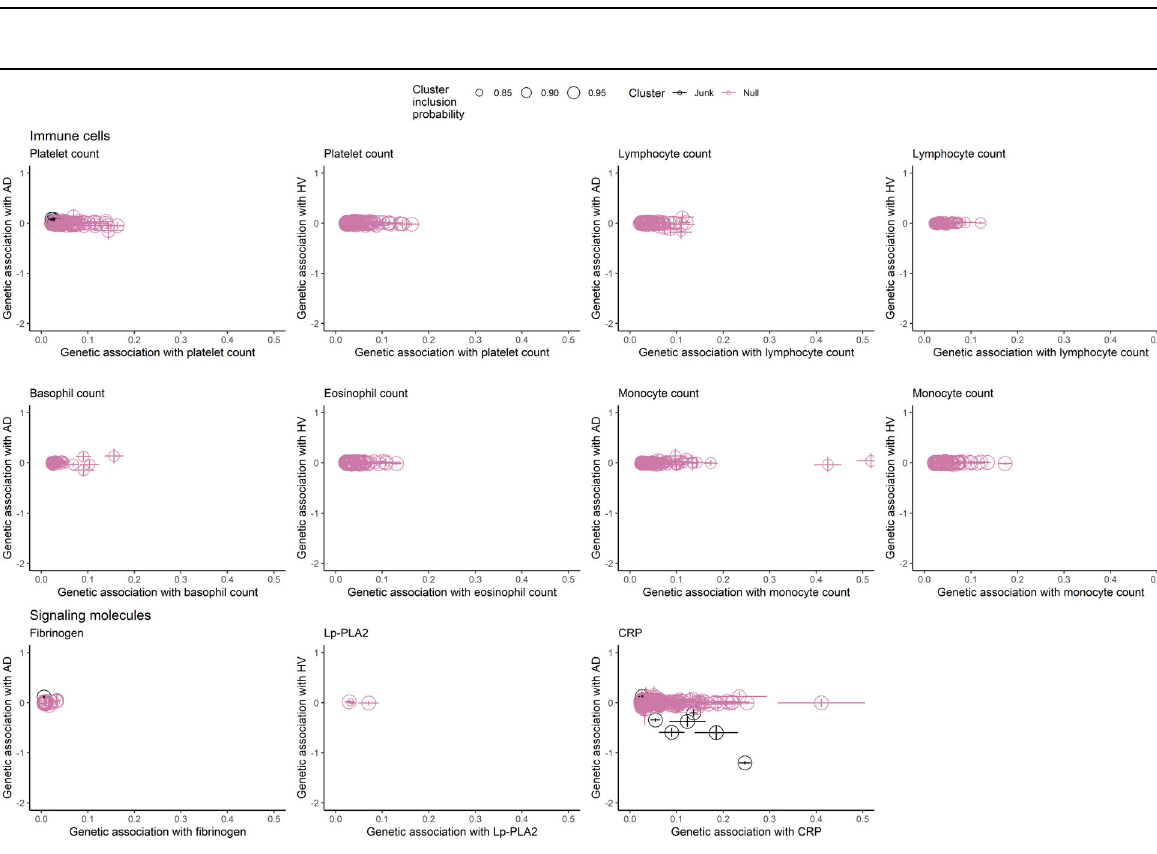
Fig. 3 Exploration of heterogeneity by cluster analyses. Shown are the genetic associations for the individual variants with the exposure and outcome; lines indicate con fi dence intervals. When restricting to a cluster probability assignment of ≥ 0.8 and ≥ 4 variants per cluster, no clusters of variants were identi fi ed. AD, Alzheimer ’ s disease; CRP, C-reactive protein; HV, hippocampal volume; Lp-PLA2, lipoprotein-associated phospholipase A2. The junk cluster denotes variants with estimates that do not fi t in any